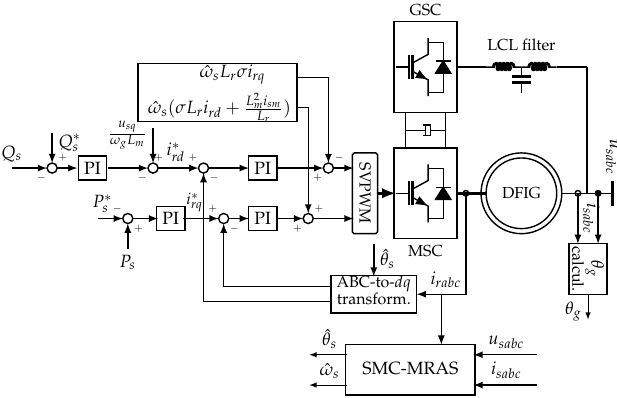
Figure 1. The sensor-less control